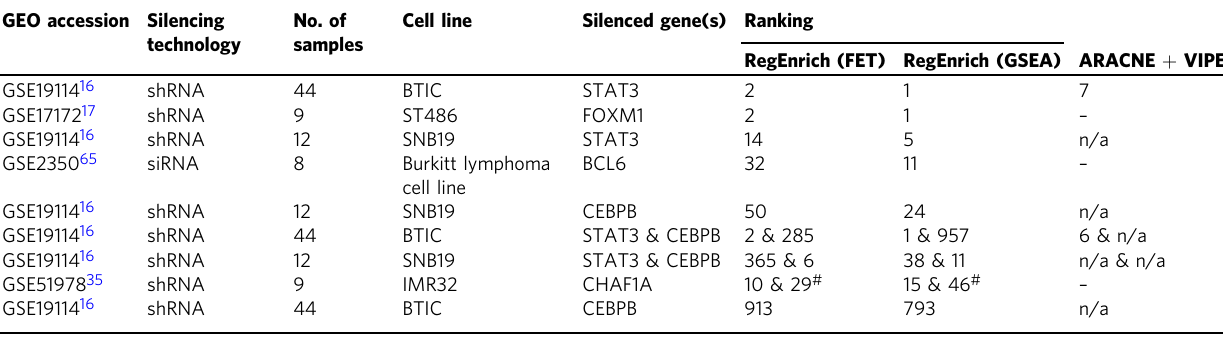
Table 1 The transcription regulators identi fi ed by RegEnrich and VIPER in gene-silencing studies * . GEO accession Silencing No. of Cell technology samples